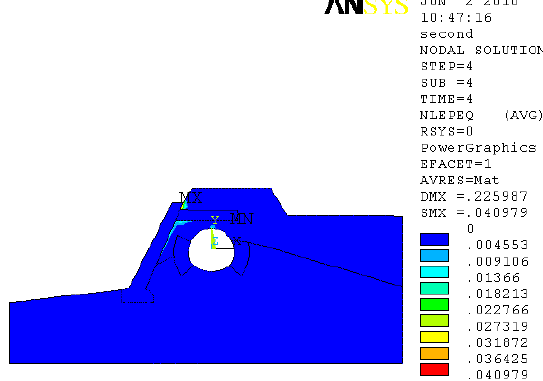
Fig. 10 Distribution of plastic zone of surrounding